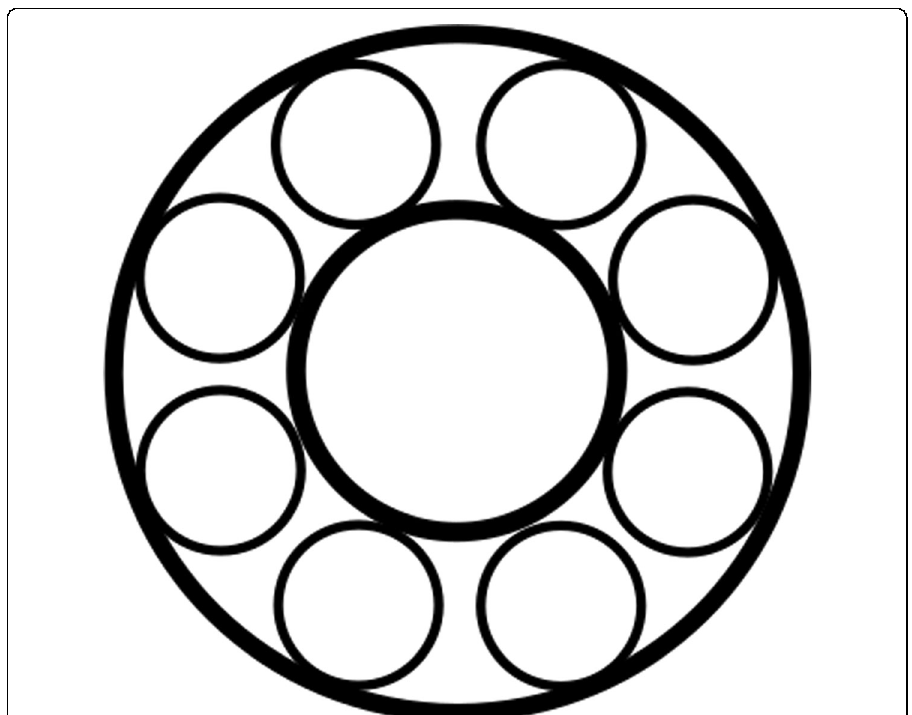
Fig. 14 Legend: Small circles indicate linguistic boundaries, i.e., home countries, which are only connected through the inner circle, which presents English as shared